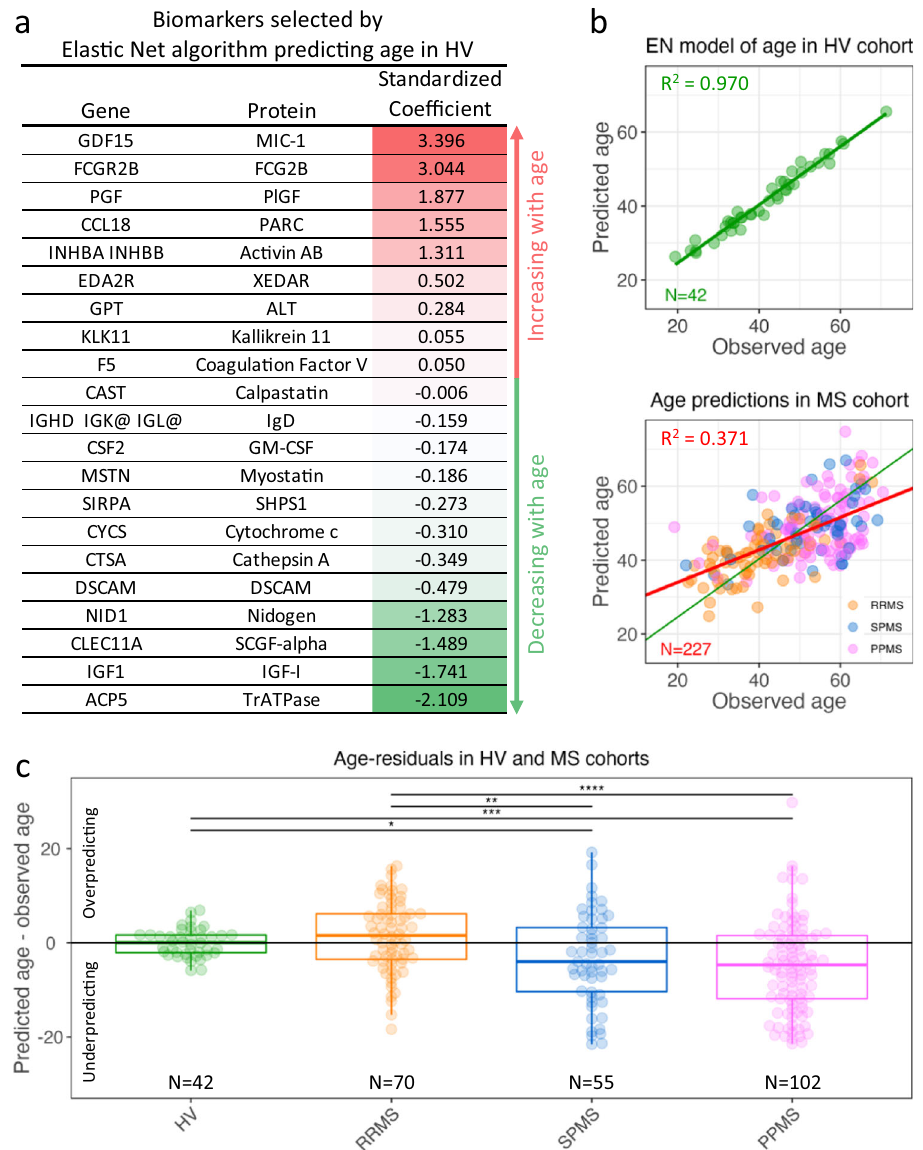
Fig. 4 | MS is not associated with accelerated aging. a Standardized regression coef fi cients from the elastic net (EN) model predicting age in the healthy volun- teers (HV). Red-shading corresponds to biomarkers that increase with age, and green-shading corresponds to biomarkers decreasing with age. b Observed vs model-predicted age in the HV cohort (top) and multiple sclerosis (MS) cohort (bottom). The linear regression line (red) of observed vs predicted MS samples is superimposed on the green regression line of the HV cohort. The coef fi cient of determination( R 2 )oftheredlineshowsthatcerebrospinal fl uid(CSF)biomarkers explain almost 40% of variance associated with age of MS patients. c Difference between CSF model-predicted ages and observed ages ( y -axis) in HV and MS subtypes ( x -axis). The black bars mark signi fi cant differences based on pairwise measured MS-DSS (Fig. 6c, left panel, Rho=0.395, R 2 =0.166, CCC= 0.306; p =6.5×10 – 5 ), BVD severity model captured 22% of variance of measured values (Fig. 6c, middle panel, Rho=0.470, R 2 =0.219, CCC= 0.400; p =1.1×10 -5 ) and MS-DSS at follow-up captured 26% of variance (Fig. 6c, right panel, Rho=0.505, R 2 =0.264, CCC=0.430; p =2.4×10 – 7 ). This hierarchy of model validation (i.e., MS-DSS at baseline <BVD severity <MS-DSS at follow-up) was identical to the hierarchy with which outcomes correlated with individual CSF proteins.